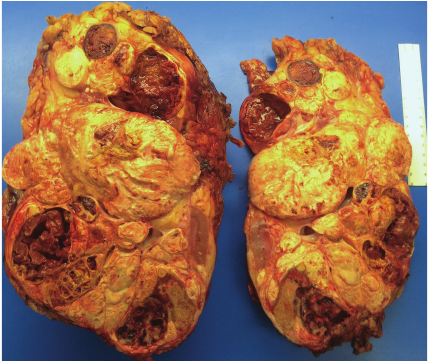
Figure 2: Gross left kidney with mucinous tubular and spindle cell carcinoma.